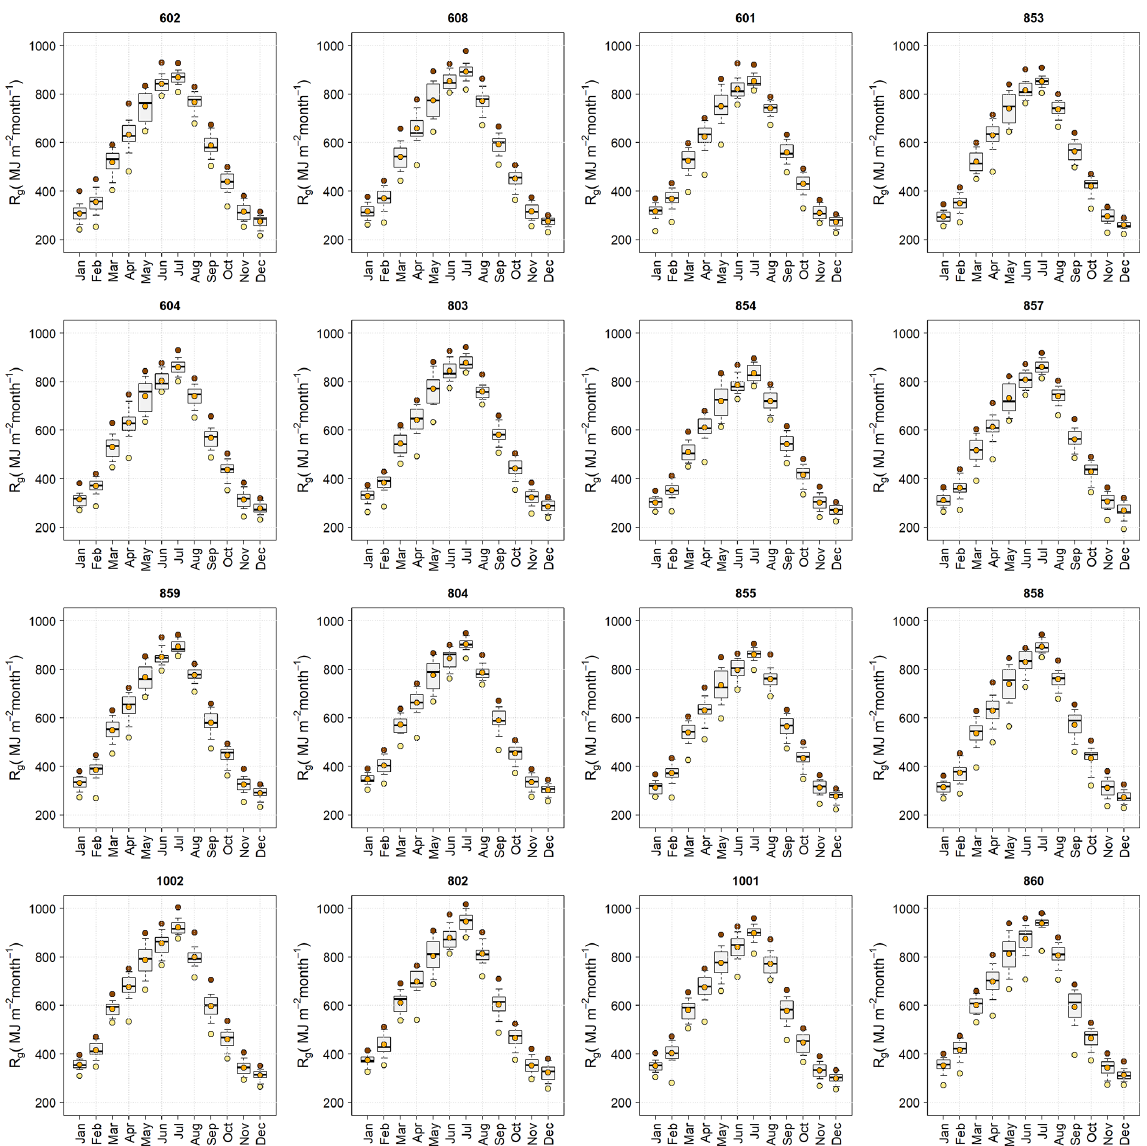
Figure 7. Statistical distribution of monthly R g (MJm − 2 per month) time series at each of the selected stations over the study area. The box shows 50% of the data, delimited by Q1 (lower) and Q3 (upper); the solid line represents the median; and whiskers show the 10th and 90th percentiles. Brown, orange, and yellow dots represent monthly maximum, mean, and minimum time series values. Stations are sorted by increasing altitude from left to right and from the top to the bottom